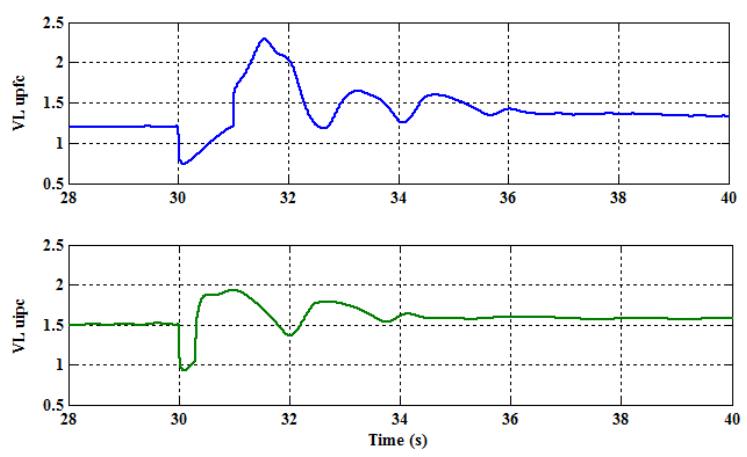
Figure 10. The output voltage of the UPFC and UIPC at the connection point.